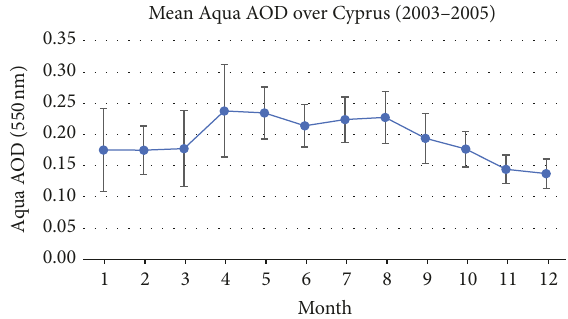
Figure 5: Spatial mean and standard deviation of Aqua AOD values over Cyprus for the period